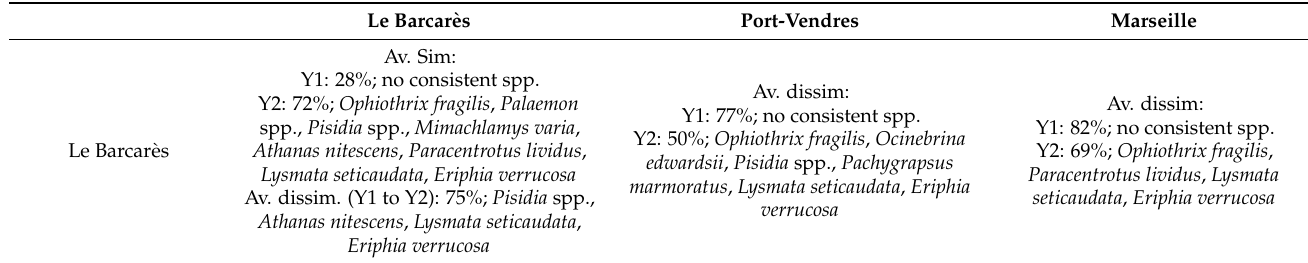
Table 2. Similarity Percentage analysis of invertebrate assemblages in surveyed Dock Biohuts through time. Species consistently contributing to the average similarity within (sim/SD > 2), and dissimilarity between (diss/SD > 2) harbours from Year 1 (Y1) to Year 2 (Y2) identified in one-way SIMPER analysis are